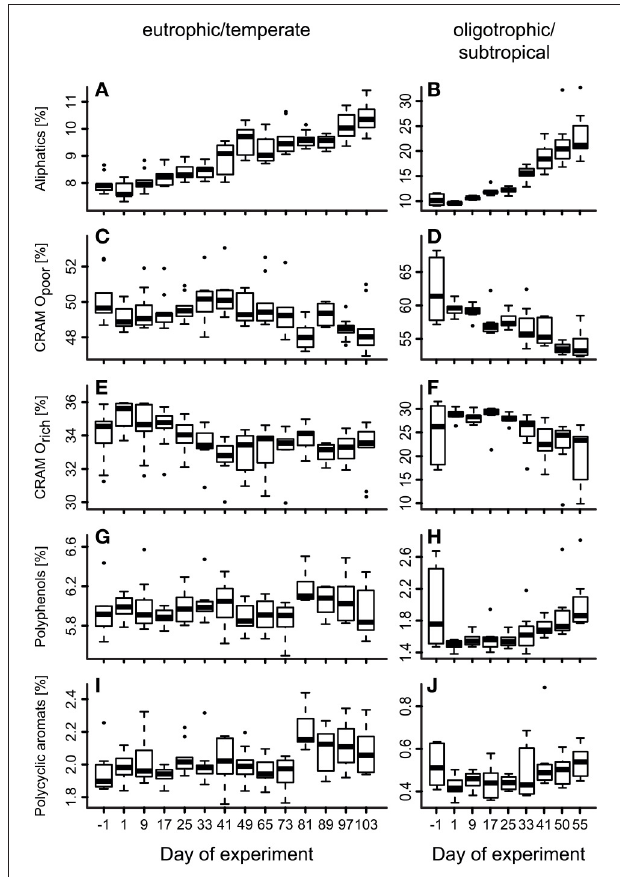
FIGURE 5 | Succession of different compound groups over experiment time. Box-Whisker plots display the different compound groups as defined in the Materials and Methods section in (A) , (C) , (E) , (G) , (I) a eutrophic/temperate mesocosm experiment in a Swedish Fjord ( Zark et al., 2015a) and (B) , (D) , (F) , (H) , (J) the oligotrophic/subtropical mesocosm experiment presented in this paper as percentage of cumulative signal intensities from FT-ICR-MS